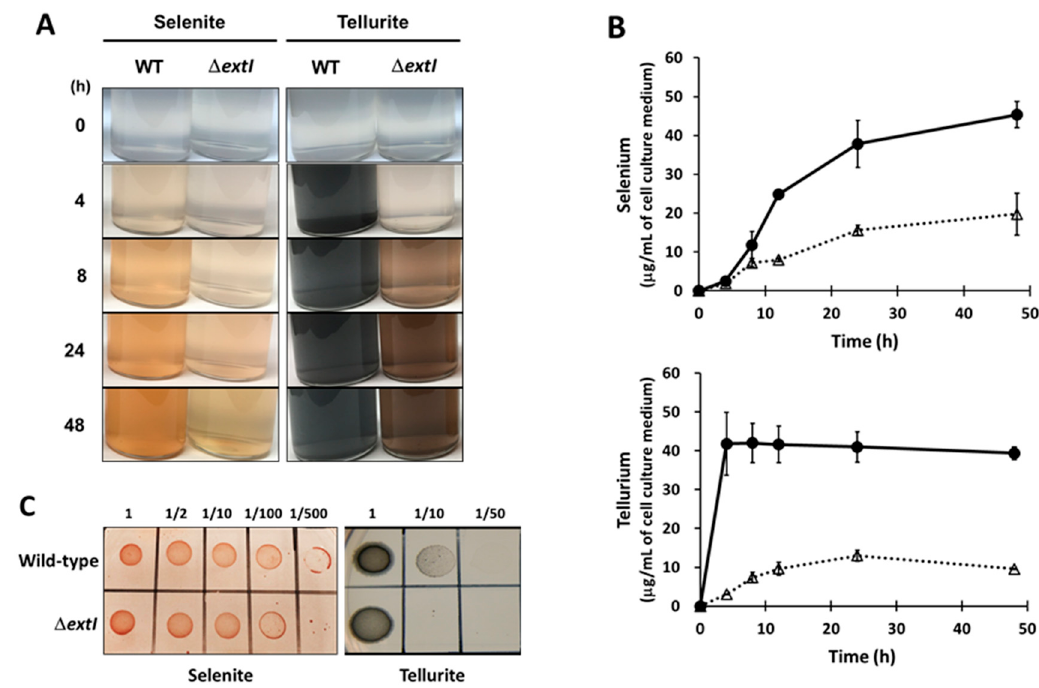
Figure 4. The effects of extI deficiency on selenite and tellurite reduction. ( A ) The colorimetric change observed during selenite and tellurite reduction. Wild-type (WT) and extI -deficient mutant ( ∆ extI ) cells were anaerobically cultured in FWA medium containing 500 µM selenite (left panels) or 500 µM tellurite (right panels) as only the electron acceptors; ( B ) wild-type (circle and solid line) and ∆ extI (triangle and dotted line) cells were anaerobically cultured in FWA medium containing 500 µM selenite (upper panel) or 500 µM tellurite (lower panel) as the sole electron acceptor. The amounts of selenium and tellurium precipitated were measured by HG-AFS. Experiments were conducted independently two times and error bars represent standard deviation; ( C ) selenite and tellurite susceptibility. The wild-type and ∆ extI cells were anaerobically cultured in NBAFYE medium. After adjusting for bacterial OD, cells were diluted as indicated with saline and spotted onto the NBAFYE agar plate with 500 µM selenite (upper panel) and 500 µM tellurite (lower panel), and then cultured for 3 days.